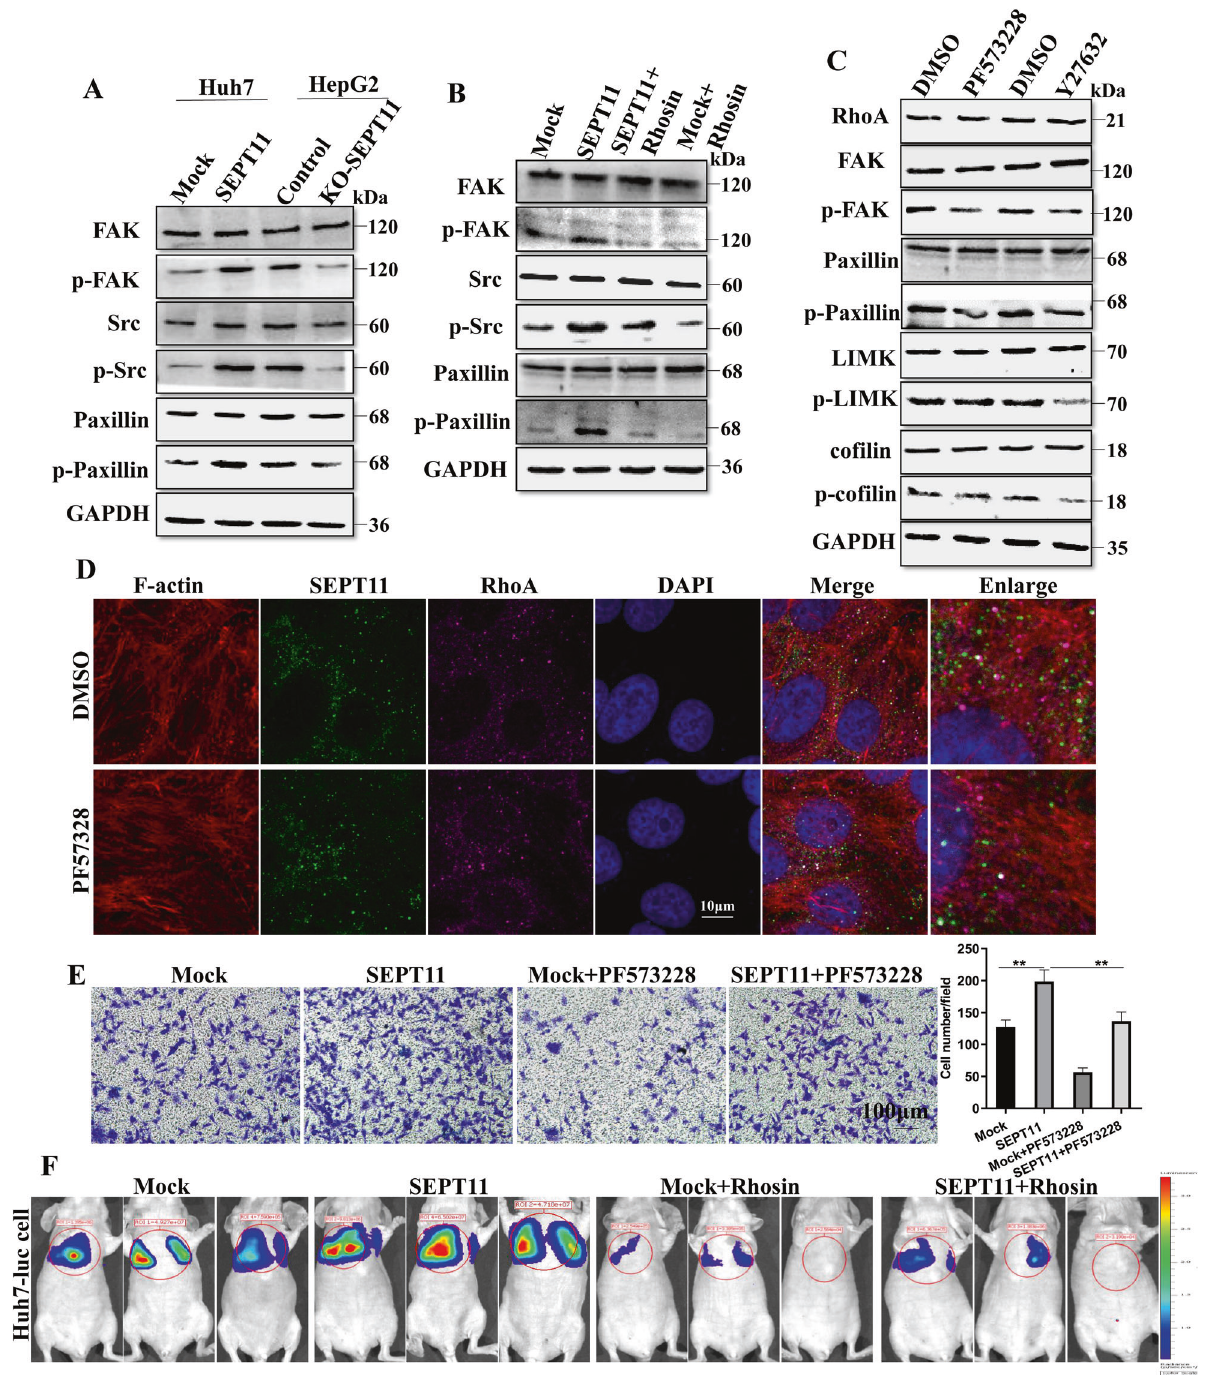
Fig. 6 SEPT11 activates FAK/Src/paxillin signaling to promote HCC migration. A WB detection of the effect of SEPT11 expression on FAK/ Src/paxillin signaling; B WB detection of the effect of RhoA on SEPT11-activated FAK/Src/paxillin signaling; C WB detection of Y27632 and FAK inhibitor PF573228 on FAK/Src/paxillin and LIMK/co fi lin pathways; D The effect of PF573228 on actin arrangement and thickness detected by cellular immuno fl uorescence. E Detection of the effect of PF573228 on SEPT11-promoted cell migration; F Huh7-luciferase cells were injected into the tail vein of nude mice, and two groups of mice were treated with Rhosin (30 mg/kg) by intraperitoneal injection, then observed and photographed on the 28th day. SEPT6 signi fi cantly promoted the proliferation, cell cycle transition, invasion and migration in HCC cells in vitro and tumor metastasis migration and invasion of HCC cells, and SEPT6 gene knockout has in vivo, which is consistent with the functions of other septins in a signi fi cant inhibitory effect on the survival of HCC cell lines [50]. tumors. It has been reported that the elevated expression of SEPT9 However, our study found that SEPT11 had no signi fi cant effect and SEPT2 in glioma tissues and cell lines not only promote cell on tumor cell proliferation either in vivo or in vitro, and the high invasion but also enhance cell proliferation [49]. Overexpression of Cell Death and Disease (2023)